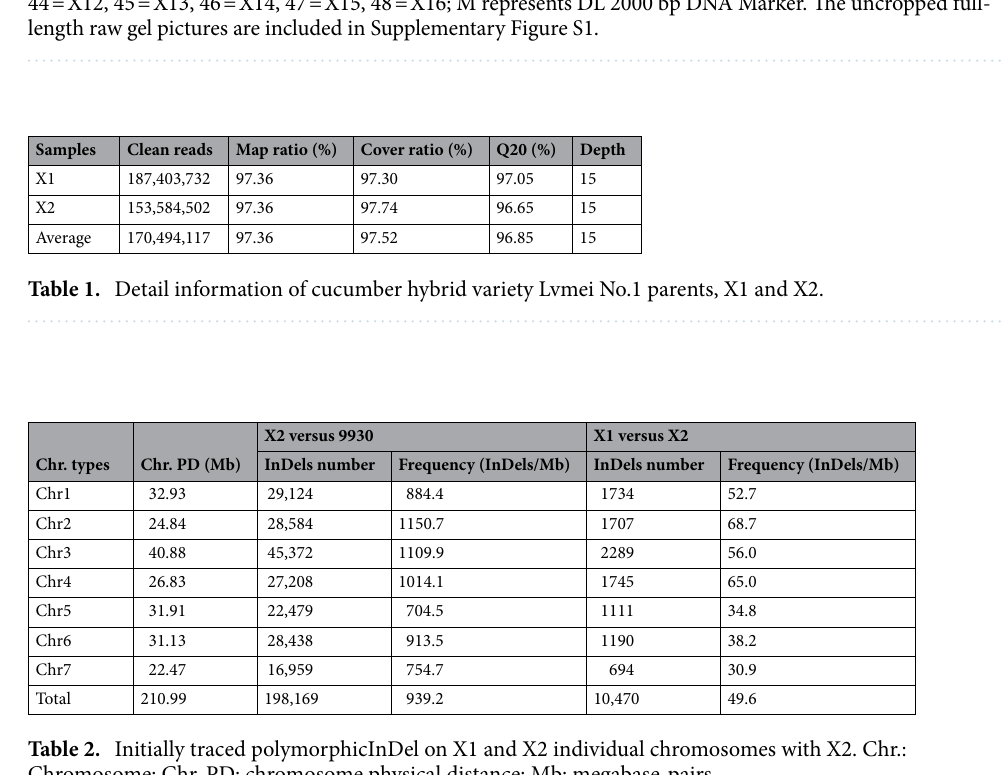
Figure 1. A display of cucumber lines fruits morphology and agarose gel resolvability of lnDel markers. Dense spiny cucumber ( A ), female parent ( B ) and male parent ( C ) of Lvmei No.l hybrid variety, Lvmei No.l hybrid variety ( D ), f ruit cucumber ( E ), White-green and black spiny cucumber ( F ), White green cucumber ( G ), White Green sparsely spin y cucumber ( H ), Yellow Green sparsely spiny cucumber ( I ). Agarose gel electrophoresis monograph for poly morphism analysis ( J – Q ); hybrid seeds purity detection ( R – Y ) and validation of lnDel markers for 48 cucumber breeding lines ( Z – AD ); polymorphism analysis using lnDell69 ( J ), lnDel79 ( K ); lnDel115 ( L ); lnDel117 ( M ), lnDel124 ( N ); lnDel170 ( O ); and In Del114 ( P – Q ); respectively; Hybrid seeds purity testing of the elite cucumber hybrid va riety L vmei No.l using InDel79 ( R ); InDel170 ( S ), InDel114 ( T – U ), InDel124 ( V ), lnDel232 ( W ), InDel269 ( X ), and InDel48 ( Y ); respectively; Experimental validation of 48 cucumber breeding lines using In Del161 ( Z ); lnDel174 ( AB ), lnDel232 ( AC ), and lnDel269 ( AD ), X1 and X2 are the parents of elite cucumber hybrid variety Lvmei No.l while C1/C2, C3/C4 and C5/C6 are 3 couples of other three cucumber commercial hybrids while M1/M2, M3/M4 and M5/M6 constitute 3 couples for three commercial melon hybrids; F1 represent individuals of Lvmei No.l; Allele 1, Allele2 and Allele3 are three different allele generated from the 48 lines using InDel269; l = Dl, 2 = D2, 3 = D3, 4 = D4, 5 = D5, 6 = D6, 7 = D7, 8 = D8, 9 = D9, 10 = D10, 11 = D11, 12 = D12, 13 = D13, 14 = D14, 15 = D15, 16 = D16, 17 = D17, 18 = D18, 19 = D19, 20 = D20, 21 = D21, 22 = D22, 23 = D23, 24 = B1, 25 = B2, 26 = B3, 27 = B4, 28 = B5, 29 = B6, 30 = B7, 31 = B8, 32 = B9, 33 = X1, 34 = X2, 35 = X3, 36 = X4, 37 = X5, 38 = X6, 39 = X7, 40 = X8, 41 = X9, 42 = X10, 43 = X11, 44 = X12, 45 = X13, 46 = X14, 47 = X15, 48 = X16; M represents DL 2000 bp DNA Marker. The uncropped full- length raw gel pictures are included in Supplementary Figure S1.